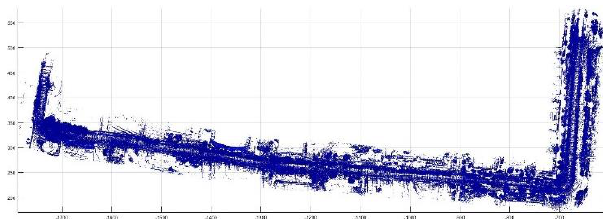
Figure 10. Dynamic map built by LiDAR-SLAM-based estimated solution with FDE.